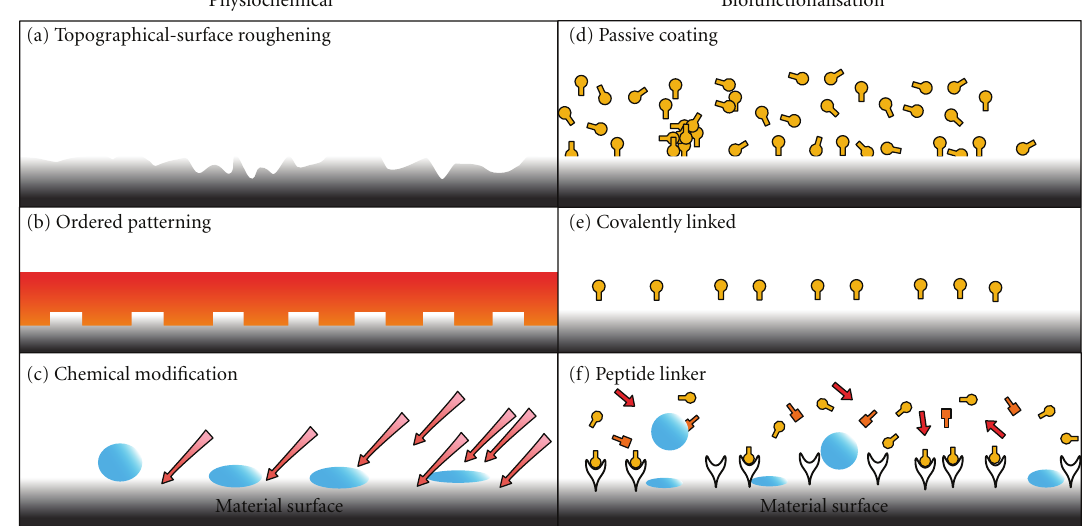
Figure 4: Examples of various physical, chemical, and biofunctionalisation techniques to enhance haemocompatibility. Biofunctionalised surfaces interact with cell surface receptors, that is integrins. Whereas physiochemical modification can influence cell-material interactions through charge, topography, and attractive/repulsive forces due to hydrophobic and hydrophilic interactions [26].